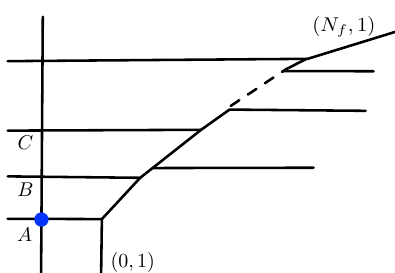
Figure 2 . The blue node denotes the D3-brane. We can also put the D3-brane on other intersection points { A , B , C , · · · } . Intersection points denote vacua of the theory, which compose the Higgs branch. Each intersection point can be regarded as a local conifold singularity on the dual toric diagram through M-theory/type-IIB duality